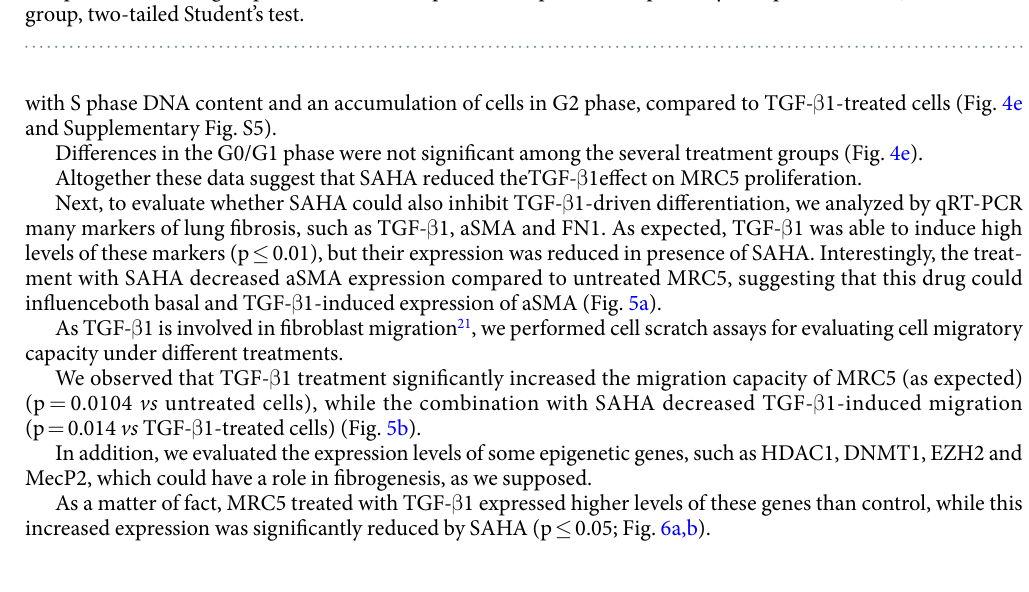
Figure 5. SAHA hinders TGF- β 1-induced cell differentiation into myofibroblasts. ( a ) Quantitative RT-PCR results of pro-fibrotic genes (TGF- β 1, FN1, aSMA) in MRC5 treated with or without SAHA and/or TGF- β 1. Data are expressed as Mean ( ± SD). Three independent experiments were carried out with three replicatesfor each experimental condition. ( b ) Graphical representation of wound healing assay (magnification 10x). Data were obtained by two different observers. Results shown are the mean of three independent experiments ± SD (two replicates for each treatment). One star ( * ) indicates a p ≤ 0.05, while two stars ( ** ) indicate a p ≤ 0.01, compared to control group; # and ## indicate a p ≤ 0.05, or p ≤ 0.01, respectively, compared to TGF- β 1-treated group, two-tailed Student’s